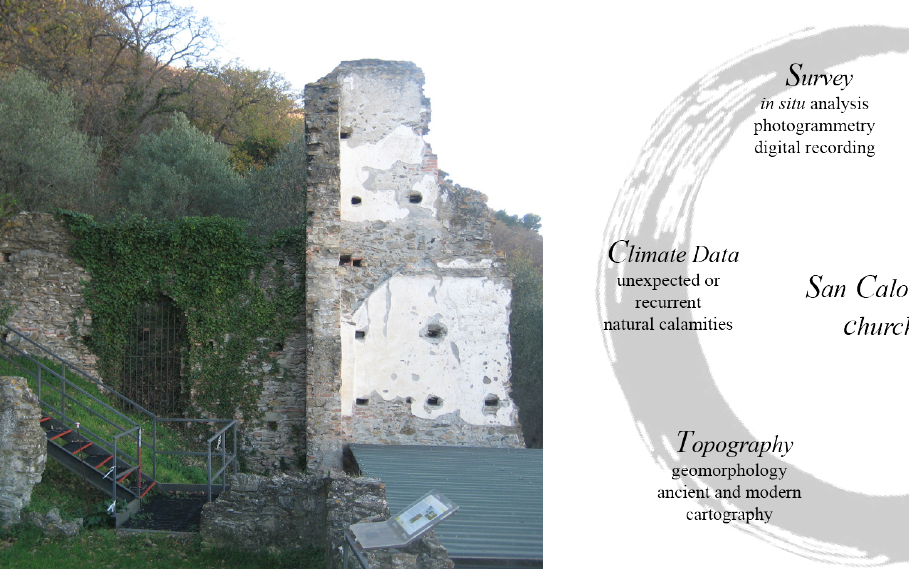
Figure 3. Circular interaction between disciplinesFigure 2. San